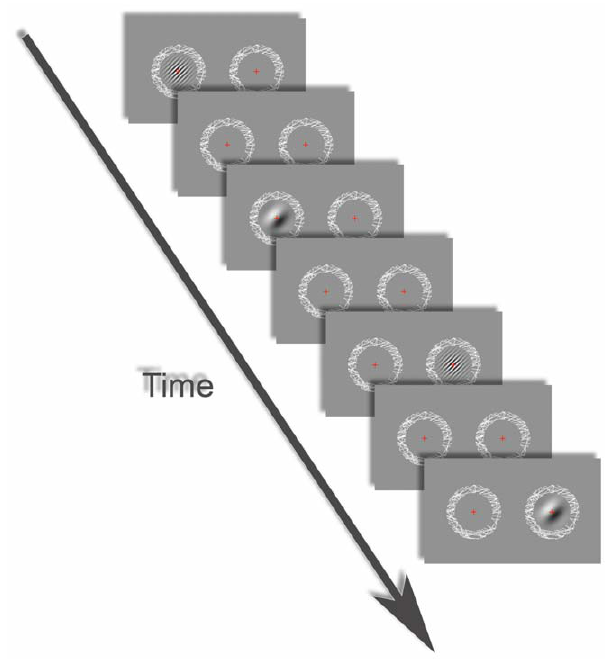
Figure 1. Illustration of the stimuli used in the experiment. Participants used free fusion to view the two rings comprising random line patterns on each side of the screen. On separate trials, we either stimulated the left or right eye, with a low or high spatial frequency grating presented inside the ring. The gratings flickered by reversing contrast polarity. In each fMRI run each stimulus condition was shown only once (as depicted here, presented in a pseudo-randomized order) and each trial lasted 19.2 s. In the behavioral experiments outside the scanner trials lasted 350 ms and 624 trials were presented per run. Stimulation trials were interleaved with fixation periods in which only the fusion rings and fixation crosses were presented.